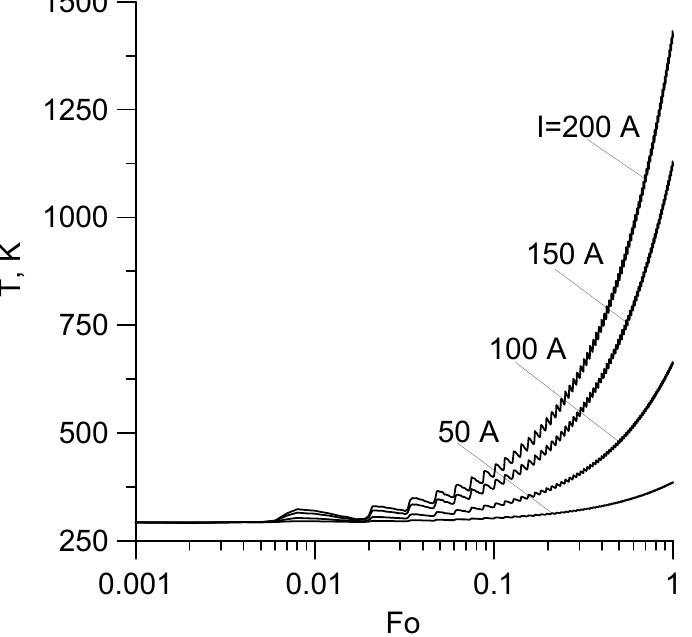
Figure 2. The temperature at the point ξ = 0.5, θ = 0°, ζ = 0.5 at different values of the Fourier number and current I .